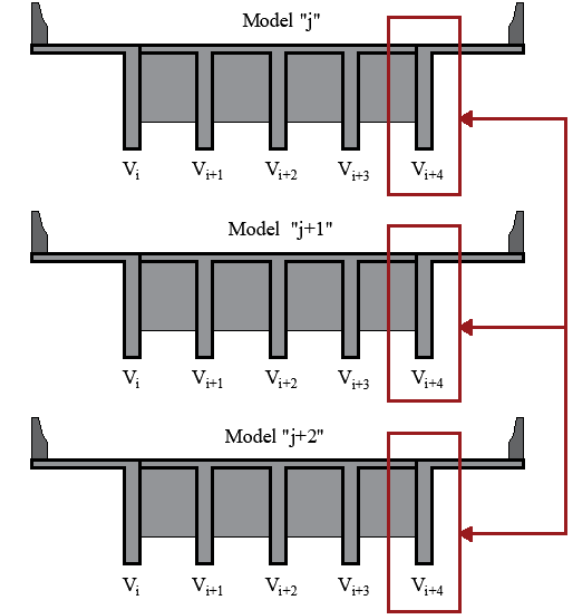
Figure 10. Methodology for Local